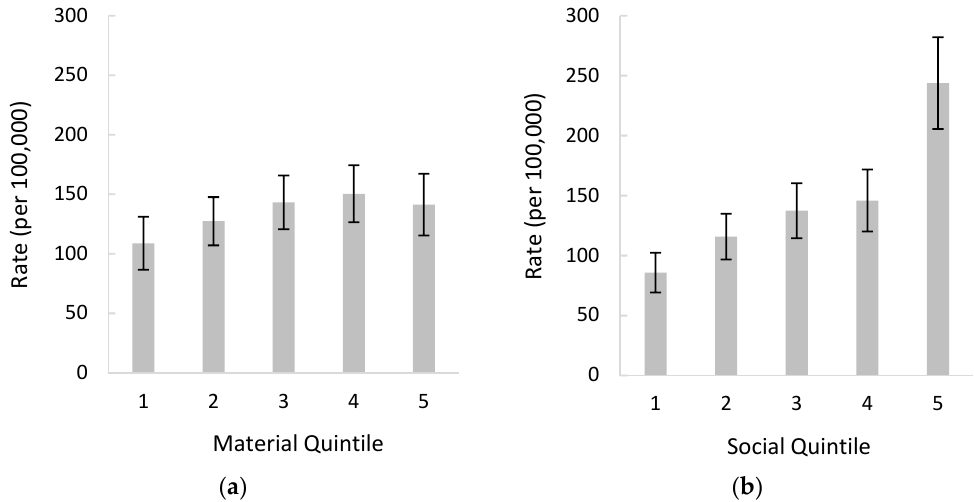
Figure 1. Self-poisoning hospitalization rates per 100,000 population in British Columbia (BC) among 10–19-year-olds, 1 April 2012 to 31 March 2020, by: ( a ) material quintile; ( b ) social quintile. Error bars display 95% confidence intervals.